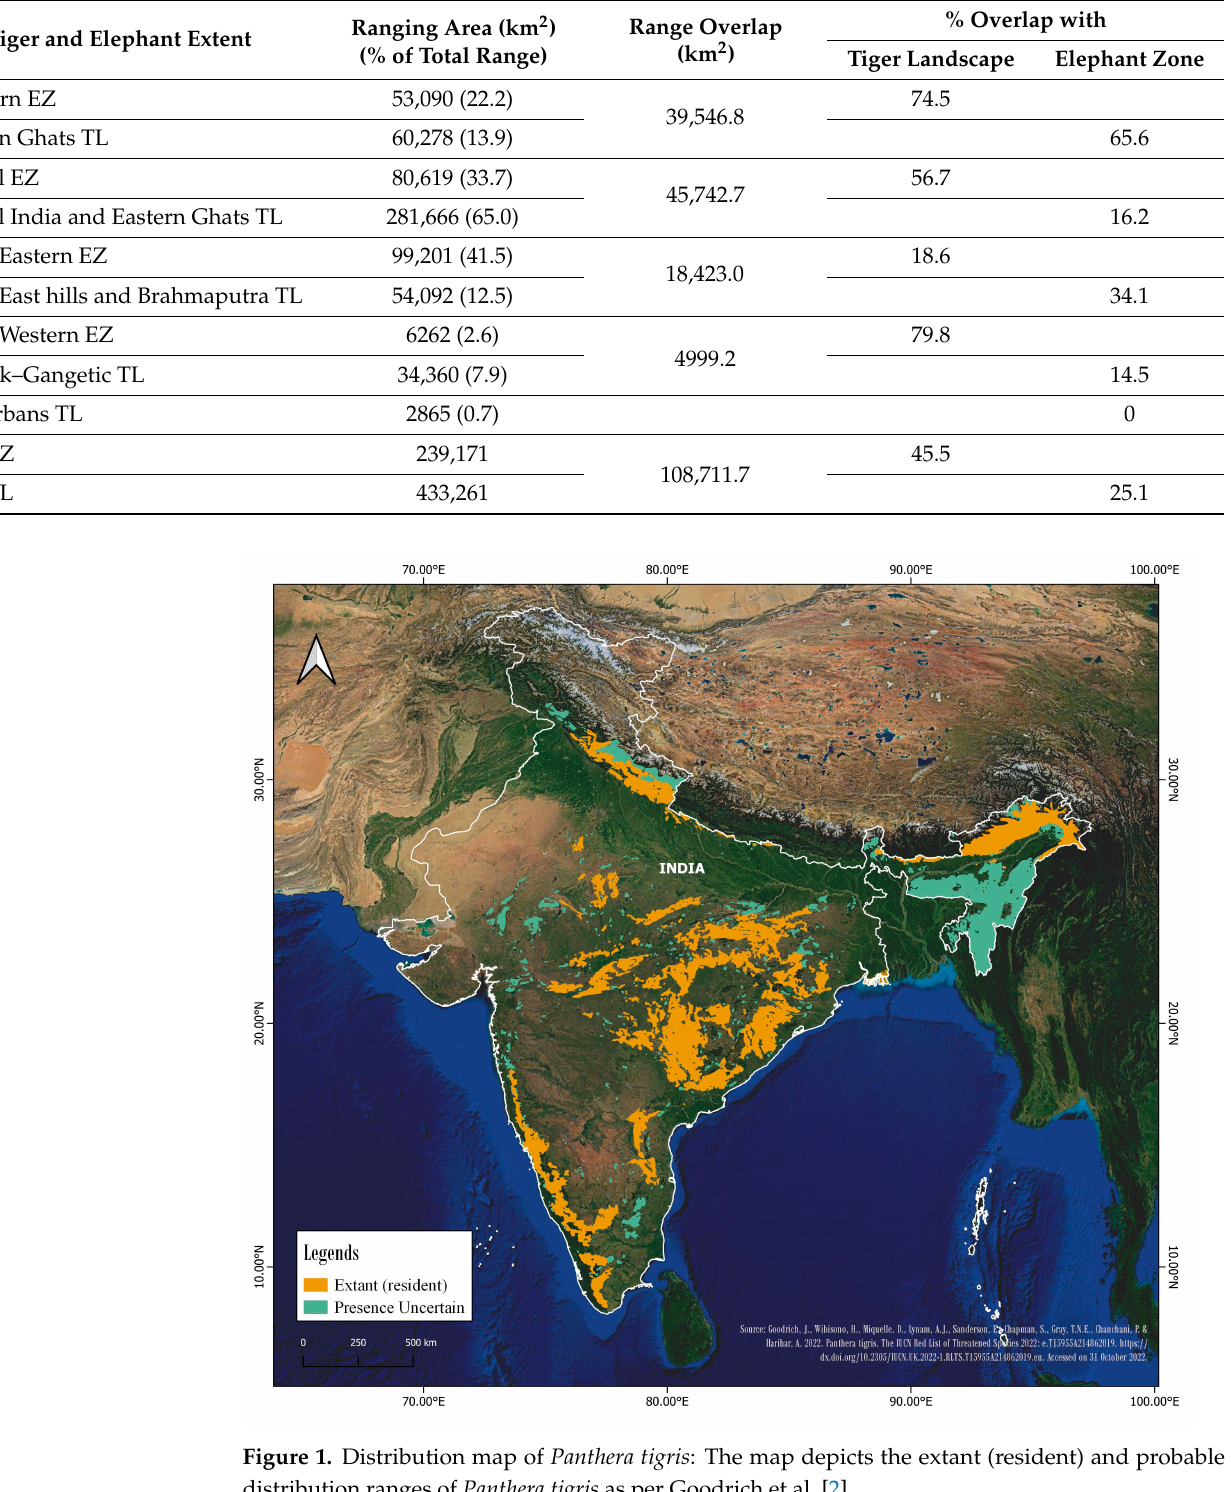
Table 1. Details of ranging areas and overlapping extant ranges of elephants and tigers in India (EZ: elephant landscape (Zone); TL: tiger landscape).